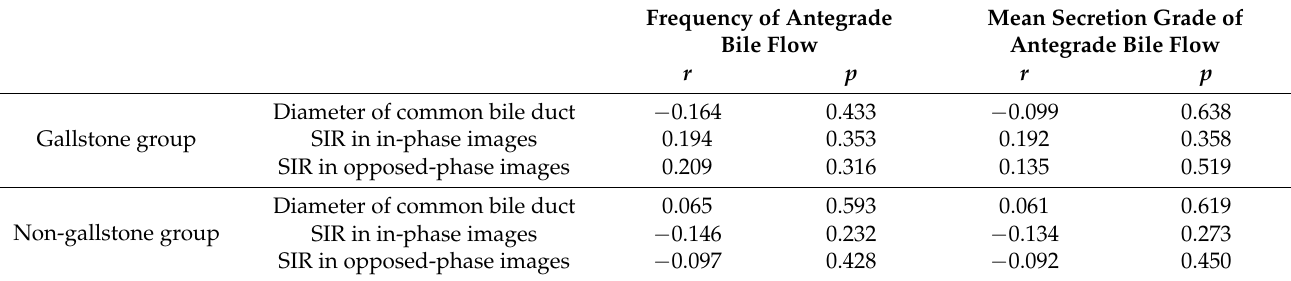
Table 2. Correlation of the mean secretion grade and frequency of antegrade bile flow with the common bile duct diameter and with the SIR of the gallbladder in the gallstone group and non- gallstone